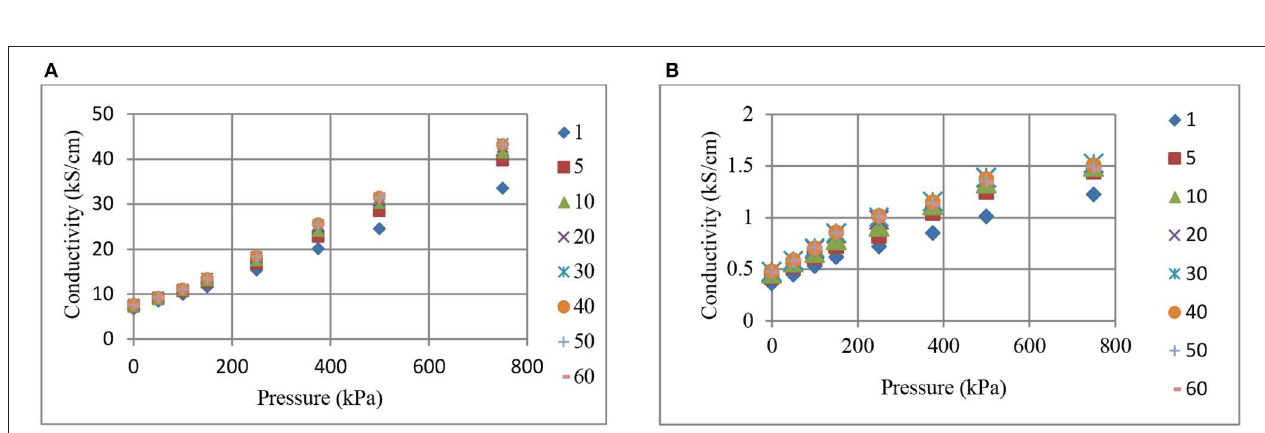
Following initial high rate compressive load application, the specimen length after 1 min may be relatively higher than what is predicted by Equation